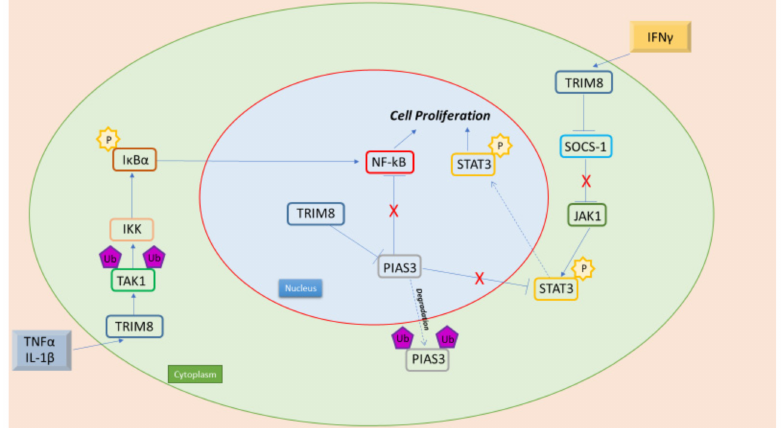
Figure 2. TRIM8 is an oncogenic protein, with its interaction with NF-kB and STAT3 leading to cell proliferation. Pro-inflammatory cytokines (TNF α e IL-1 β ) promote NF-kB activation through TRIM8. In fact, TRIM8 promotes TAK1 Lys63- linked polyubiquitination, leading to IKK kinase activation. Moreover, in the nucleus, TRIM8 promotes the translocation of PIAS3 in the cytoplasm, where it is then degraded. PIAS3 in the nucleus interacts with NF-kB preventing its activation. Furthermore, TRIM8 induces the activation of the JAK-STAT pathway promoted by IFN- γ through the degradation of two STAT protein inhibitors, PIAS3 and